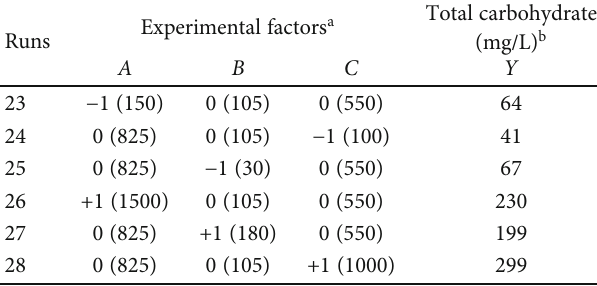
Table 3: Design matrix of augmented